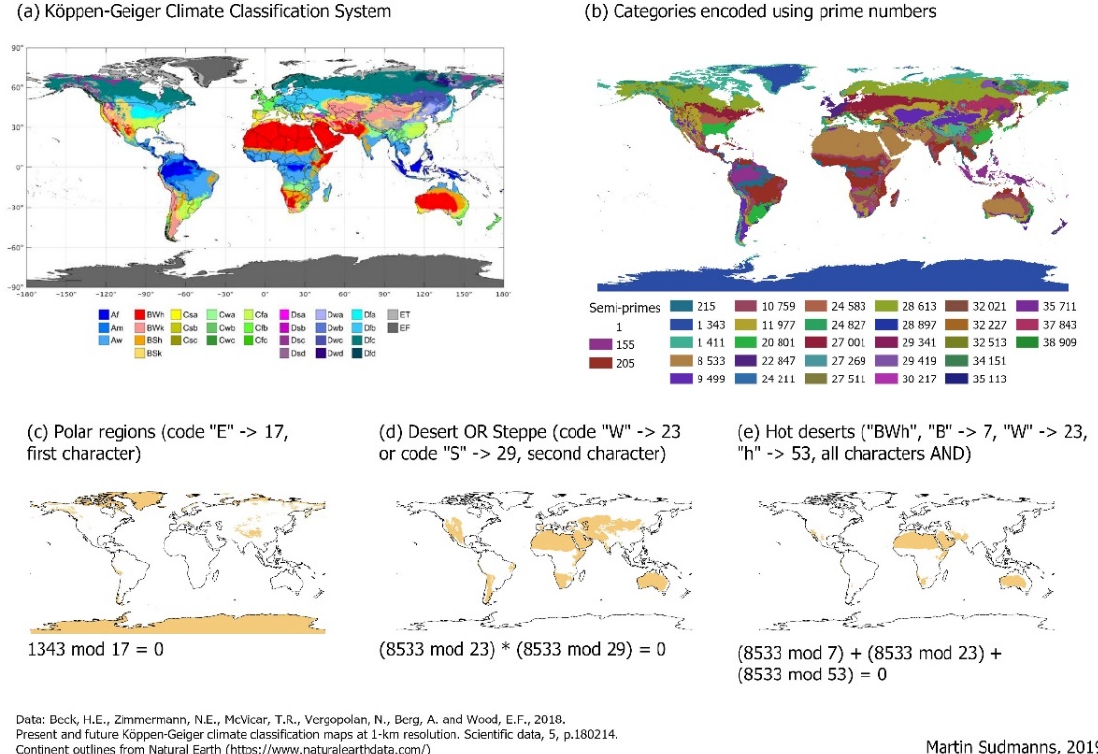
Figure 5. Köppen-Geiger climate classes with data based on [17] are encoded using prime numbers. This allows category identifiers to be selected for any topic and in any combination. ( a ) Is the original Köppen-Geiger classification, ( b ) is the encoded version using prime numbers. This illustration is for explanatory purposes only; it is not shown to the users. Three di ff erent masks on the bottom exemplarily demonstrate the access versions. ( c ) Shows a selection of polar regions from the first topic (first letter). ( d ) Shows a selection of desert or steppe from the second topic combined with OR-logic. Any cell qualifying for any of the two characteristics will be returned as a match. ( e ) Shows a combination of three codes from all topics with AND-logic. In this case, the regions with BWh climate (hot deserts) themselves are extracted.